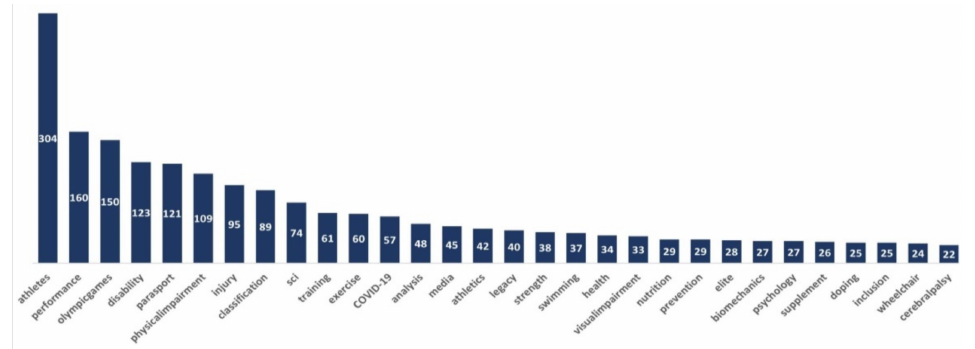
Figure 3. Number of duplicate frequencies of Top 30 keywords in Paralympic studies published from 2003 to